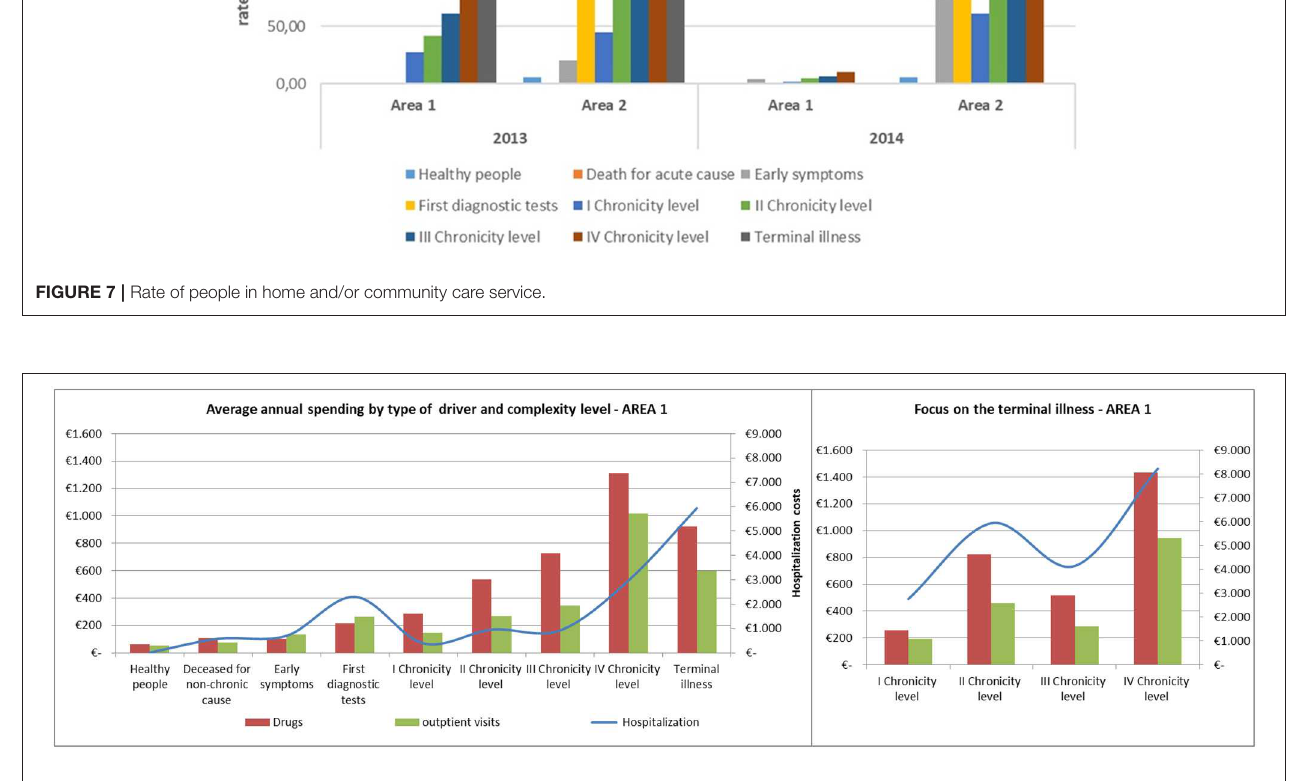
FIGURE 8 | Distribution of health spending by level of complexity.